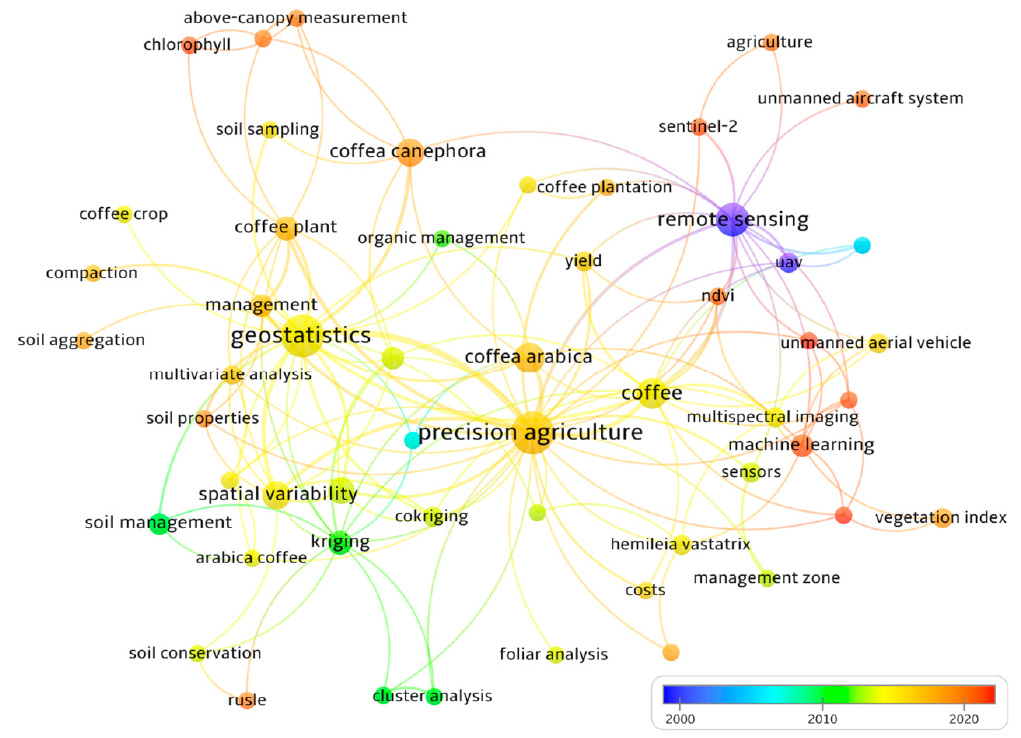
Figure 7. Map based on the co-occurrence of the authors’ keywords and evolution from 2000 to 2021/1st sem. The color scale represents the year of keyword predominance.